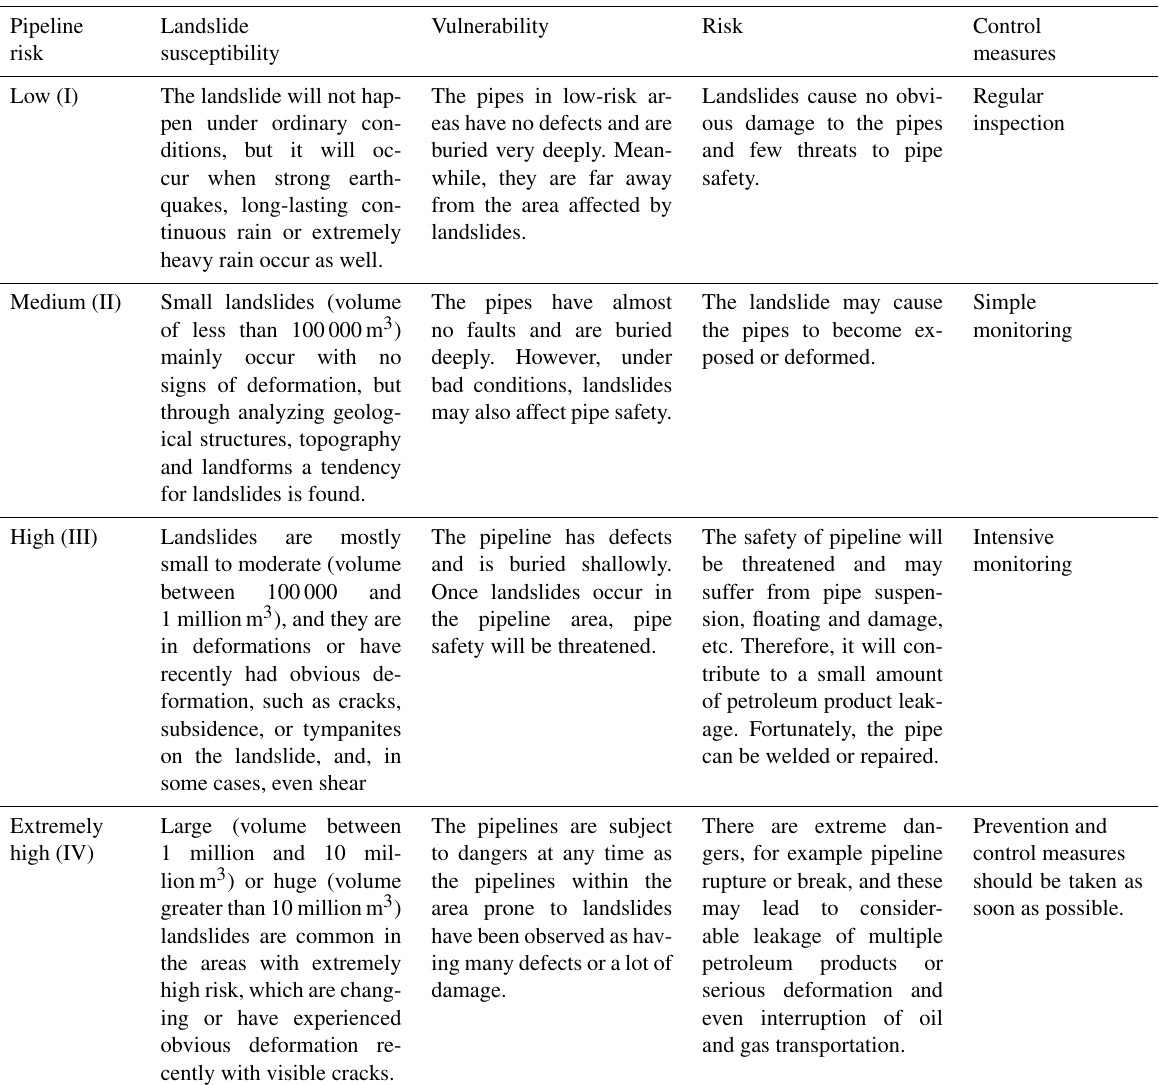
Table 6. Description of pipeline risk level.